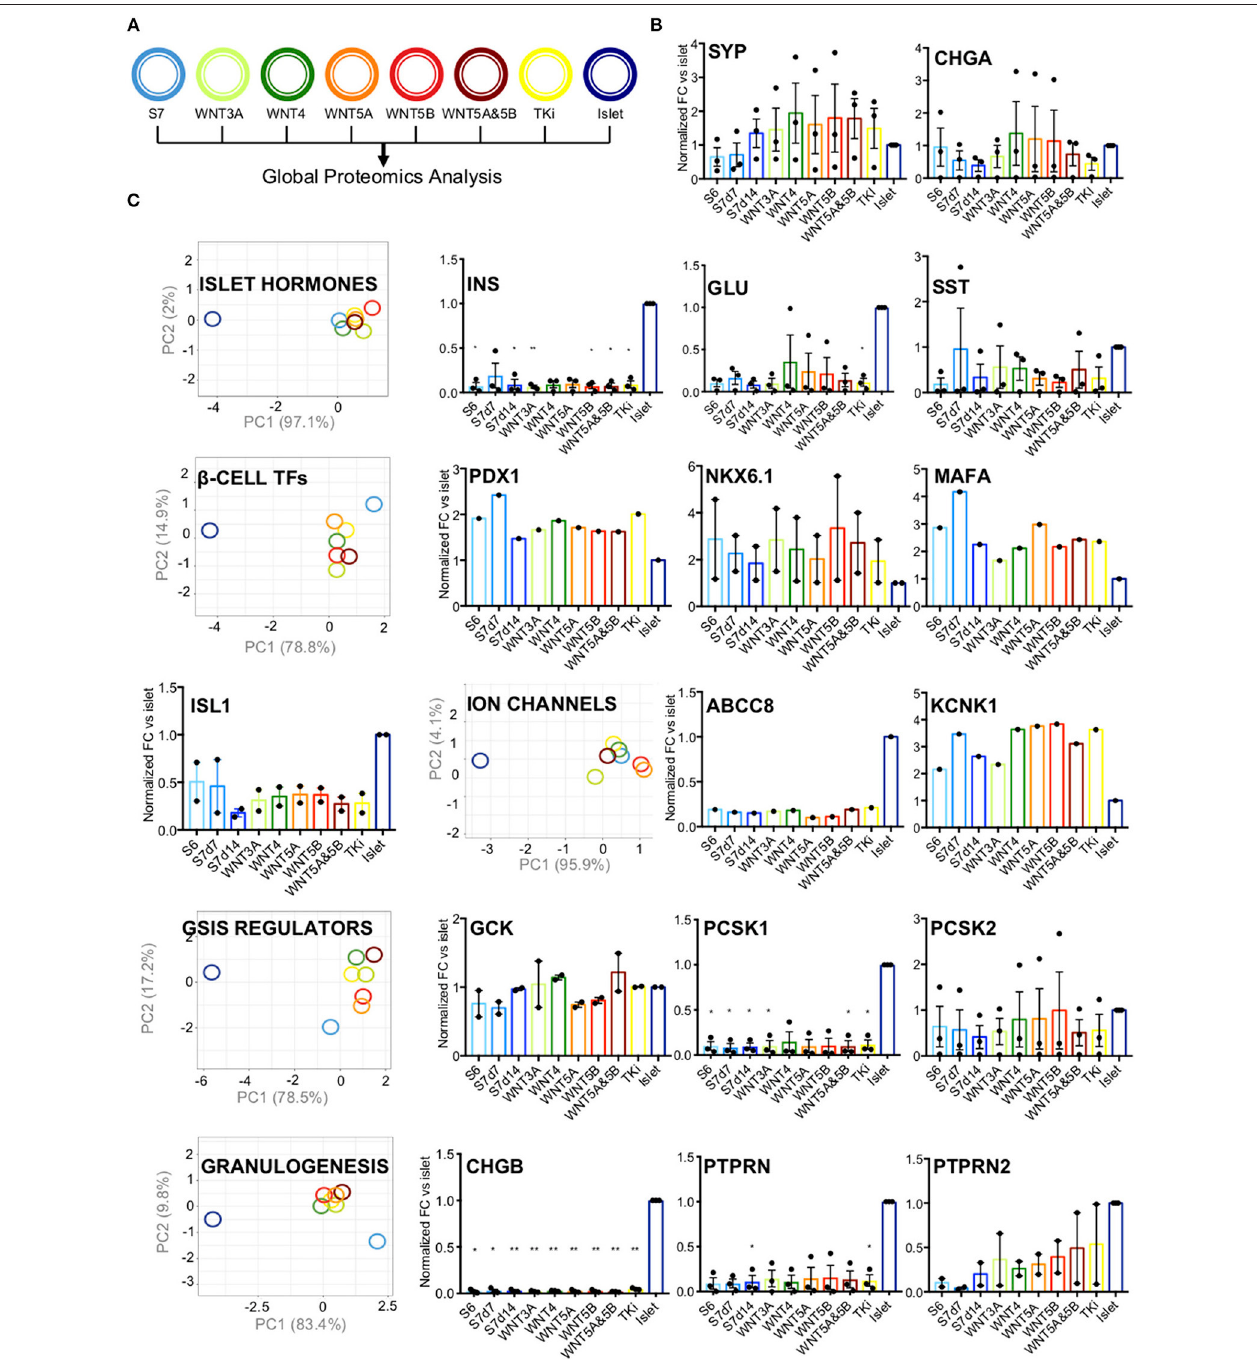
FIGURE 4 | Pancreatic endocrine markers. (A) Schematic drawing of the color code for the different samples analyzed. (B) Protein abundance of pan-endocrine markers Synaptophysin (SYP) and Chromogranin (CHGA) in S6, S7d7, S7d14, Wnt-modualted S7 cells and adult human islets. The y-axis shows normalized fold change vs. islets for each protein. The data shown is normalized protein levels from all cell lines ( n = 3, when detected) and is shown as mean with SEM. (C) PC-plots for hormones (INS, GCG, SST), transcription factors (PDX1, NKX6.1, MAFA, and ISL1), ion channels (ABCC8, KCNK1), GSIS regulators (GCK, PCSK1, PCSK2, LDHA, HK1, HK2, ALDOB) and proteins involved in granulogenesis (CHGA, CHGB, PTPRN, PTPRN2). Unit variance scaling is applied to rows. Singular value decomposition(SVD) with imputation is used to calculate principal components. X and y-axis show principal component 1 and principal component 2 that explain the % of the total variance, respectively. N = 8 data points. Also included are charts showing normalized fold change (y-axis) for each protein vs. islets. The data shown is normalized protein levels from all cell lines ( n = 3, when detected) and is shown as mean with SEM. * P < 0.05, ** P < 0.006 as vs. islets (normalized abundance level of adult human islets as reference) t -test. No significant comparisons show no